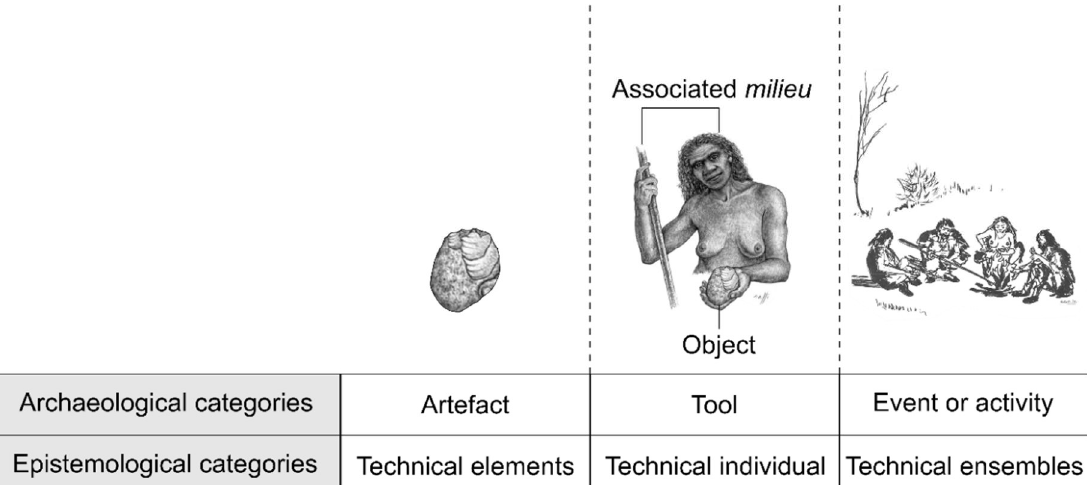
Figure 5. Conceptual correlation between the archaeological and epistemological categories used in the present work. Drawings by Maxence Raffi and Aurore de